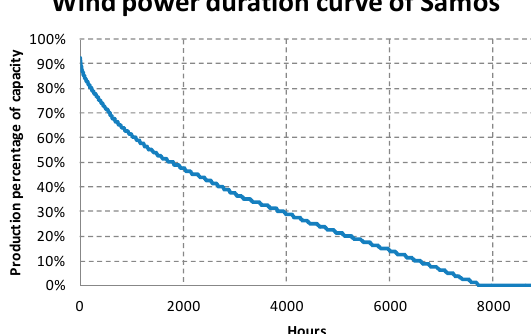
Figure 4. Duration curve of existing wind farms generated power (2015).